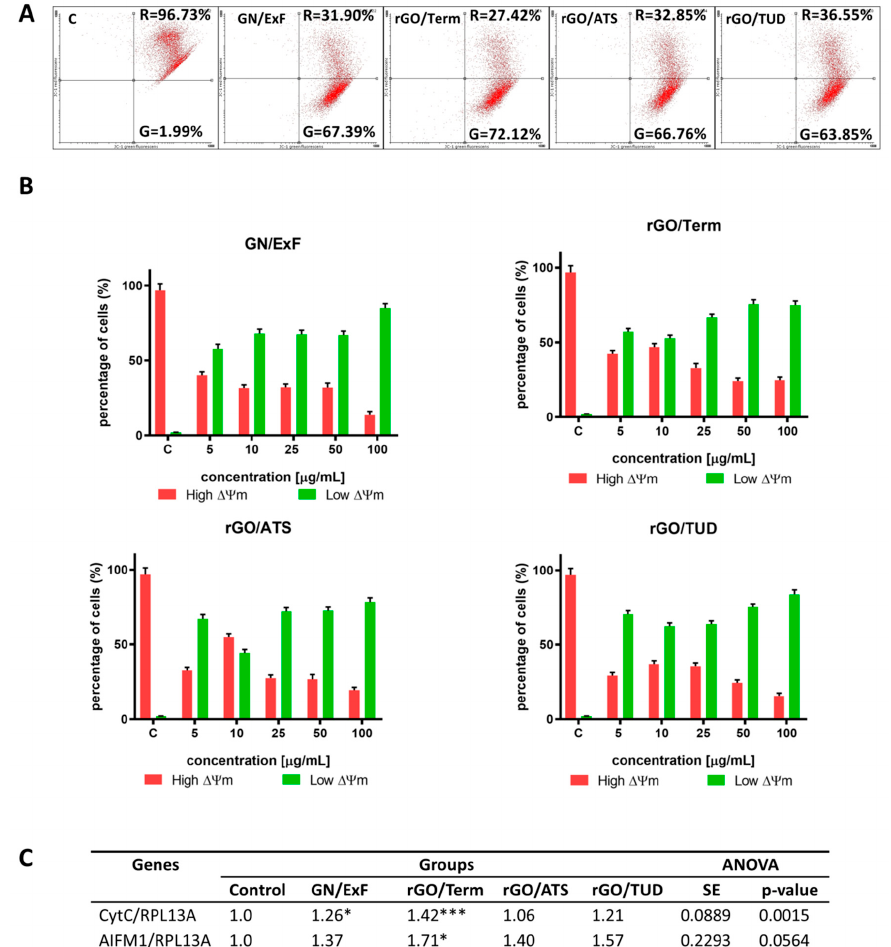
Figure 6. Mitochondrial membrane potential of U87 cells, untreated and treated with GN and rGO flakes, was evaluated using JC-1 dye and the expression of cytc and aifm1 by ∆∆ Ct method using real-time PCR. ( A ) ∆Ψ m depolarization was monitored using FACS and JC-1 as markers of mitochondrial membrane potential at 24 h post-exposure to treatment. Cytograms show cells treated with GN and rGO flakes at a concentration of 25 µ g/mL. Gated quadrant R (red and green fluorescence) includes cells with intact mitochondrial membranes (high ∆Ψ m), and quadrant G (green fluorescence) depicts cells with loss of ∆Ψ m. ( B ) Charts show percentages of cells with high and low ∆Ψ m for all the tested concentrations (5, 10, 25, 50, and 100 µ g/mL) of GN and rGOs. ( C ) The expression of cytc and aifm1 in the glioblastoma cell line U87 untreated and treated with graphene (GN) or reduced graphene oxide (rGO) flakes. Bonferroni’s multiple comparison test was used for statistical analysis. Values in rows marked with an asterisk (*) show statistically significant differences at p -value < 0.005. Values marked with one asterisk (*) indicate a p -value < 0.005, and three asterisks (***) a p -value < 0.001. Values were normalized to that of the reference house-keeping gene rpl13a . The expression level of the examined genes was expressed as the relative quantitation (RQ)